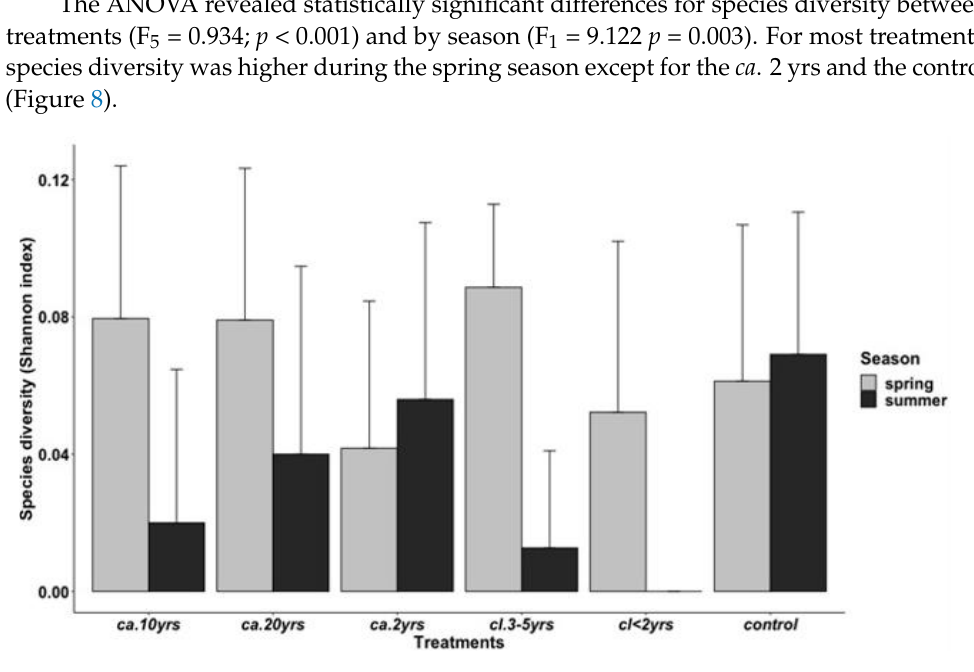
Figure 8. Mean ± SE of the species diversity of rodents of the Groenkloof Nature Reserve from areas of differing treatments of Lantana camara invasion durations ( ca. 2 yrs, ca. 10 yrs, and ca. 20 yrs), differing Lantana camara clearing times ( cl . <2 yrs and cl . 3 – 5 yrs), and a control area with no history of Lantana camara across two seasons.